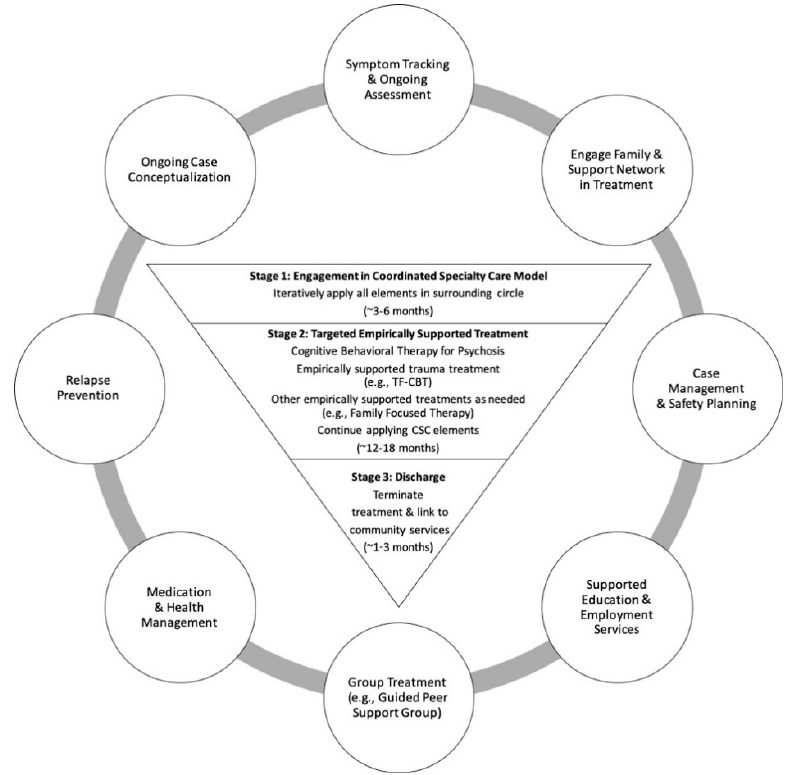
Figure 1. Integration of Cognitive-Behavioral Therapy for Psychosis and Empirically Supported Trauma Treatment within Coordinated Specialty Care: A Three-Stage Model. Note . CSC = Coordinated Specialty Care; This figure represents the three-stage approach to integrating Cognitive Behavioral Therapy for Psychosis and empirically supported trauma treatments within CSC. Key components of CSC are depicted in the outer circle as they should continue throughout the three stages. The three stages build upon one another, with each serving as a necessary foundation for subsequent stages.